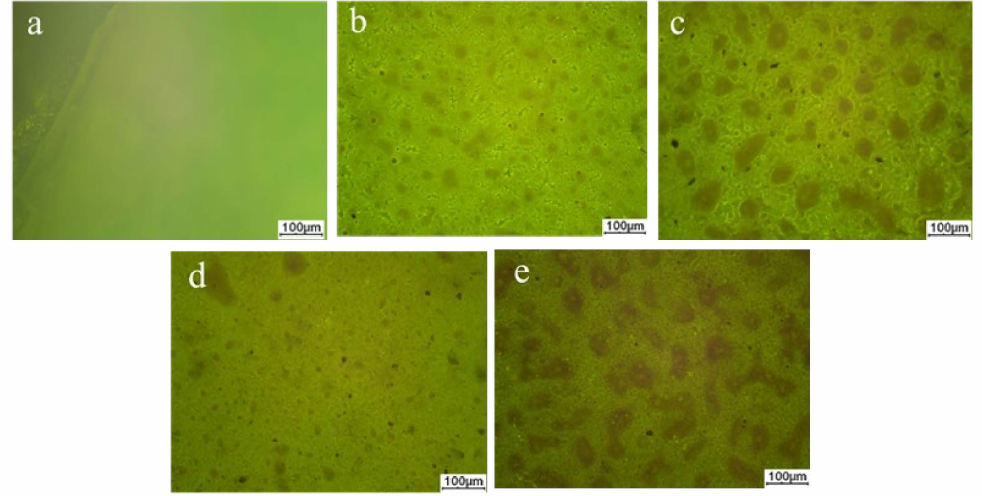
Figure 6. Microstructure of extraction oil/waterborne epoxy resin system with different contents of oxidized extraction oil. (( a ) WER, ( b ) WEO-2, ( c ) WEO-3, ( d ) WEO-4, ( e )